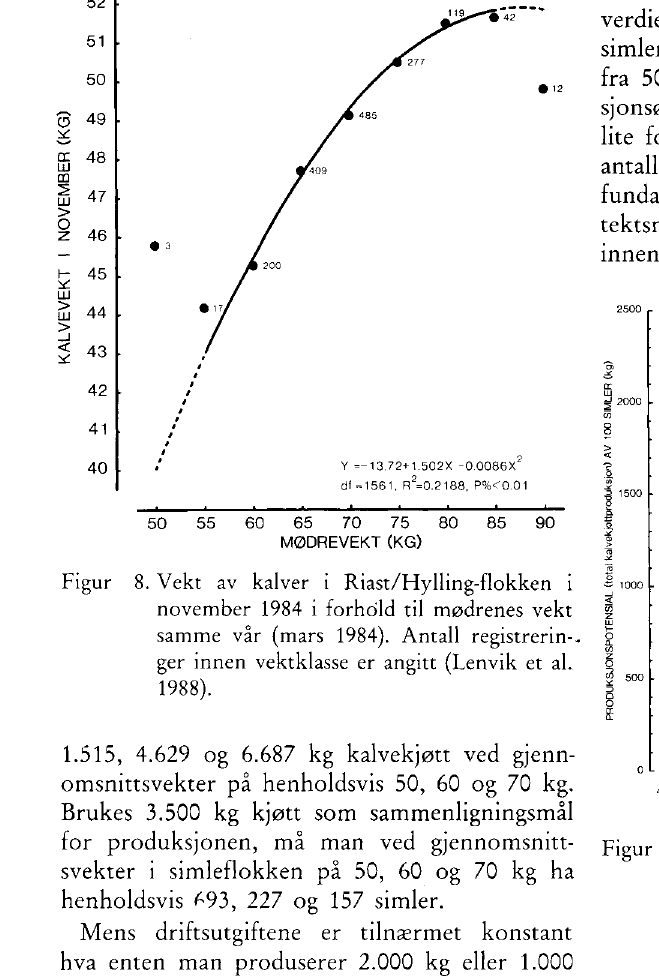
Figur 10. Kalvekjøttproduksjonspotensialet av 100 simler i forhold til middelvekten. Det er forutsatt en normalfordelt simleflokk med standardavvik på 6-8 kg. Beregningene byg ger på figur 6 (kalver som lever om høs ten), figur 8 (kalvenes vekt om høsten) og figur 9 (slakteutbytte av kalver).